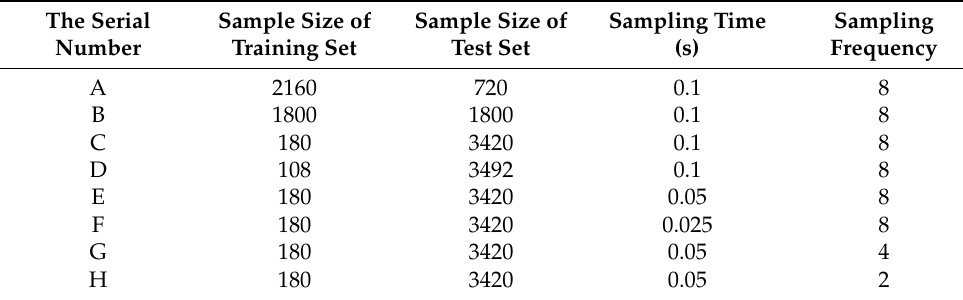
Table 6. Experimental design of model performance